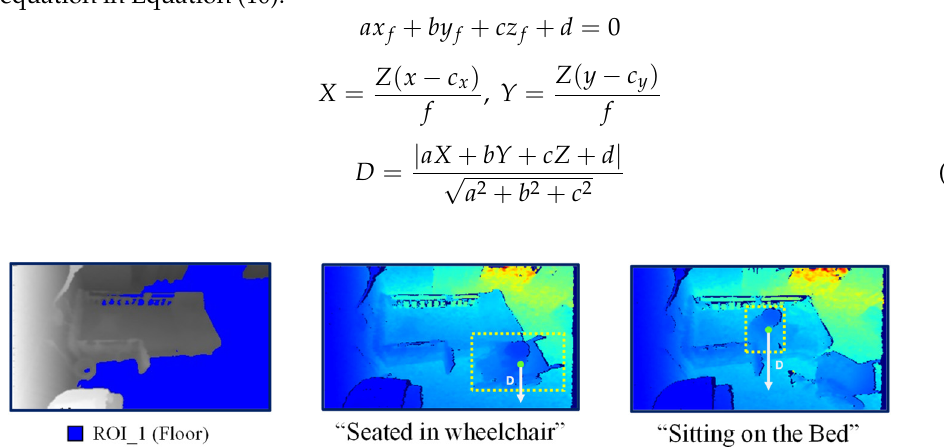
Figure 13. Examples of distance feature extraction.